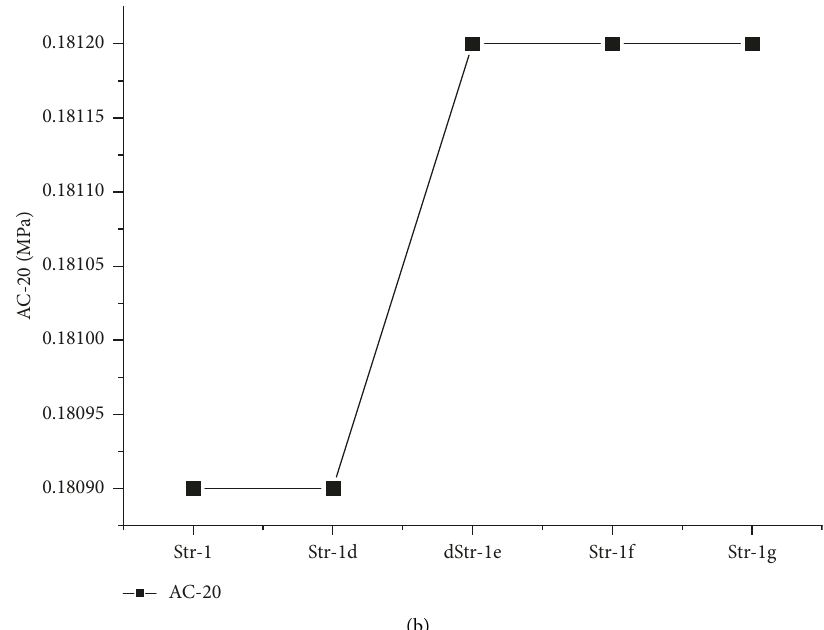
Figure 18: Maximum shear stress in the asphalt course of Str-1and Str-1d ∼ Str-1g. (a) Maximum shear stress in the upper and middle asphalt layers. (b) Maximum shear stress in the lower asphalt layer. Table 5: Simulation results of 8 pavement structures under the application of traffic loads (MPa).